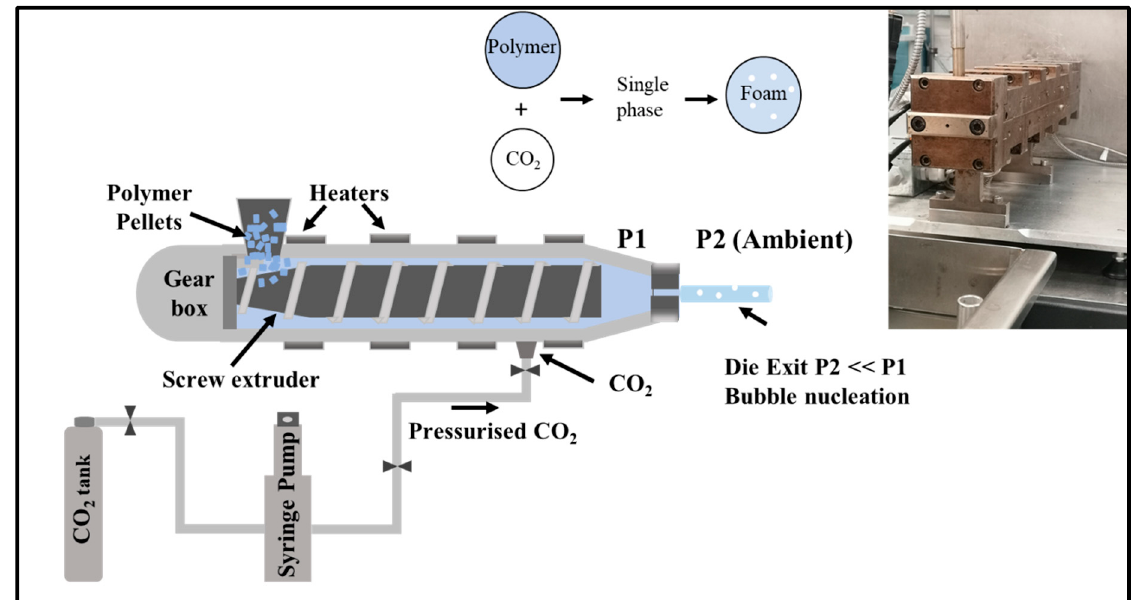
Figure 2. Schematic representation of the pressurised CO 2 ‐ assisted hot melt extrusion setup and a twin ‐ screw extruder used in this experiment (SCF Processing Ltd.) (Right corner).